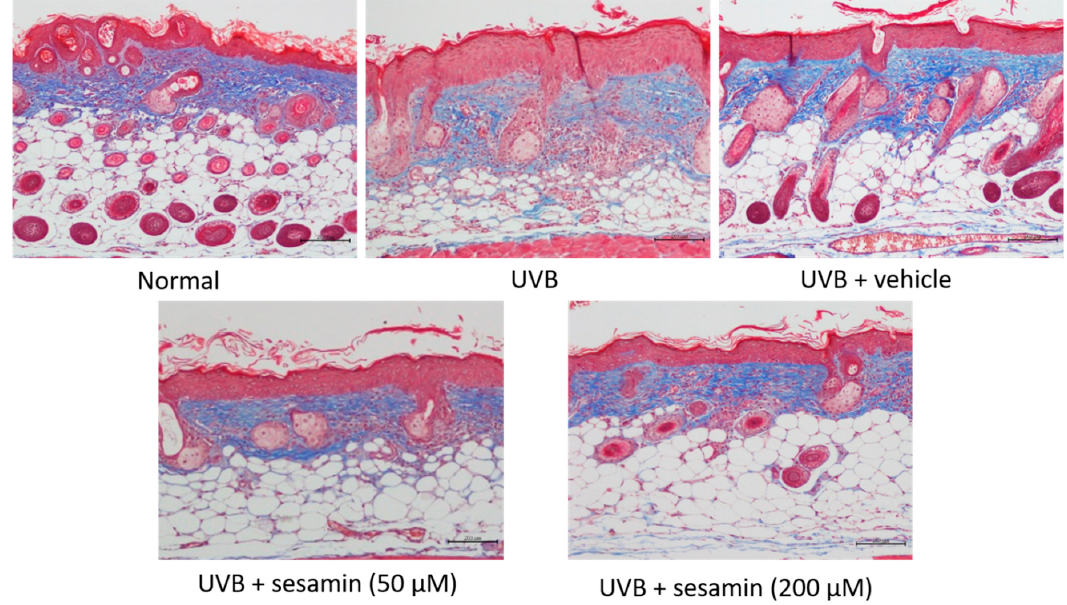
Figure 17. Effect of sesamin on the skin collagen content in chronic UVB-irradiation hairless mice. Light micrographs of histological sections stained with Masson’s trichrome in hairless mice. Collagen fibers were stained in blue.